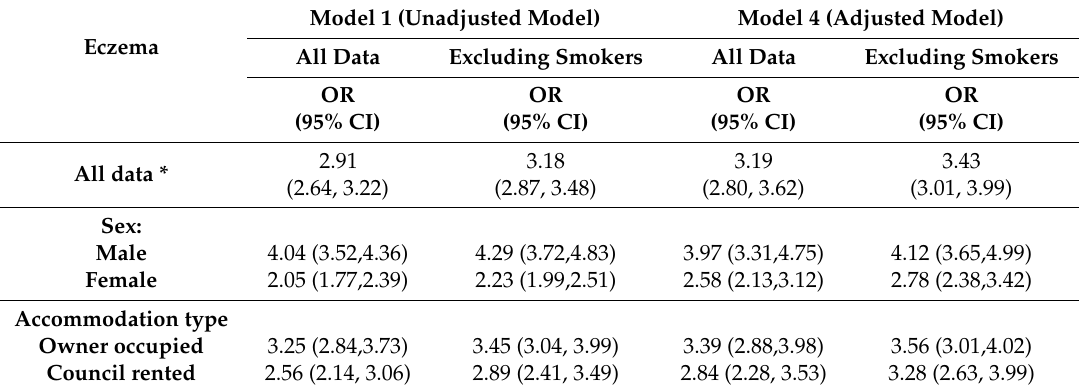
Table 5. Odds ratio (95% CI) for the association between infant eczema and onset of asthma later in childhood and as adults by using a repeated measures multilevel model for the longitudinal analysis to account for the nesting of repeated asthma events within individuals, and potential variation between waves or ages (results stratified by sex, accommodation